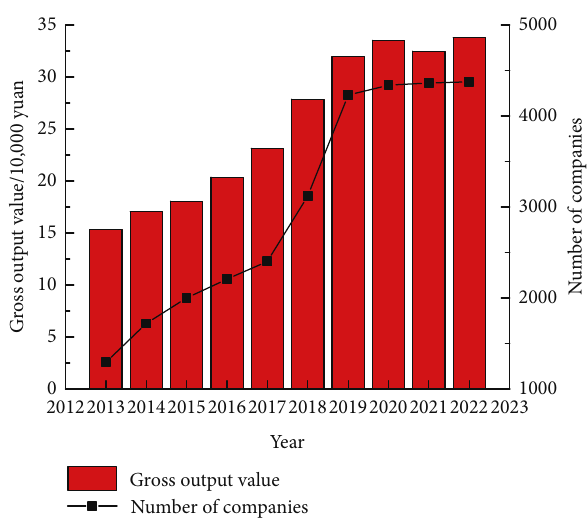
Figure 1: The change law of the total output value and the number of construction companies applying BIM in the construction industry in the past ten